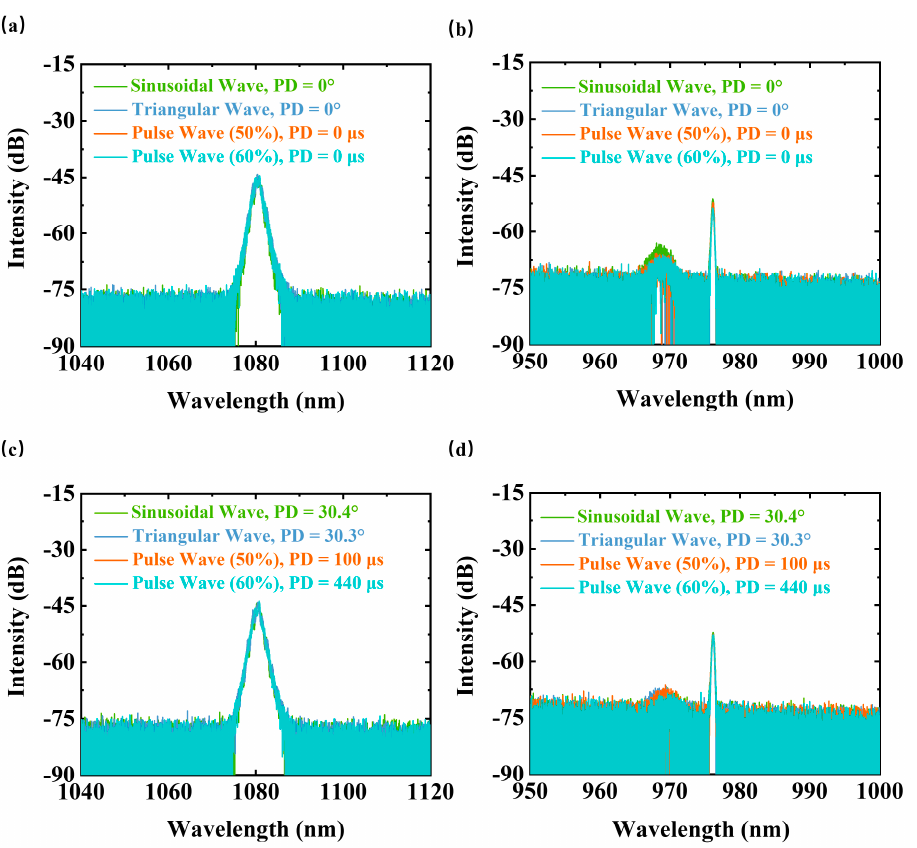
Figure 5. The laser output spectrum ( a ) and pump laser spectrum ( b ) based on pump modulation of various waveforms without phase difference. The laser output spectrum ( c ) and pump laser spectrum ( d ) based on pump modulation of various waveforms with a certain phase difference. PD: phase di ff erence.